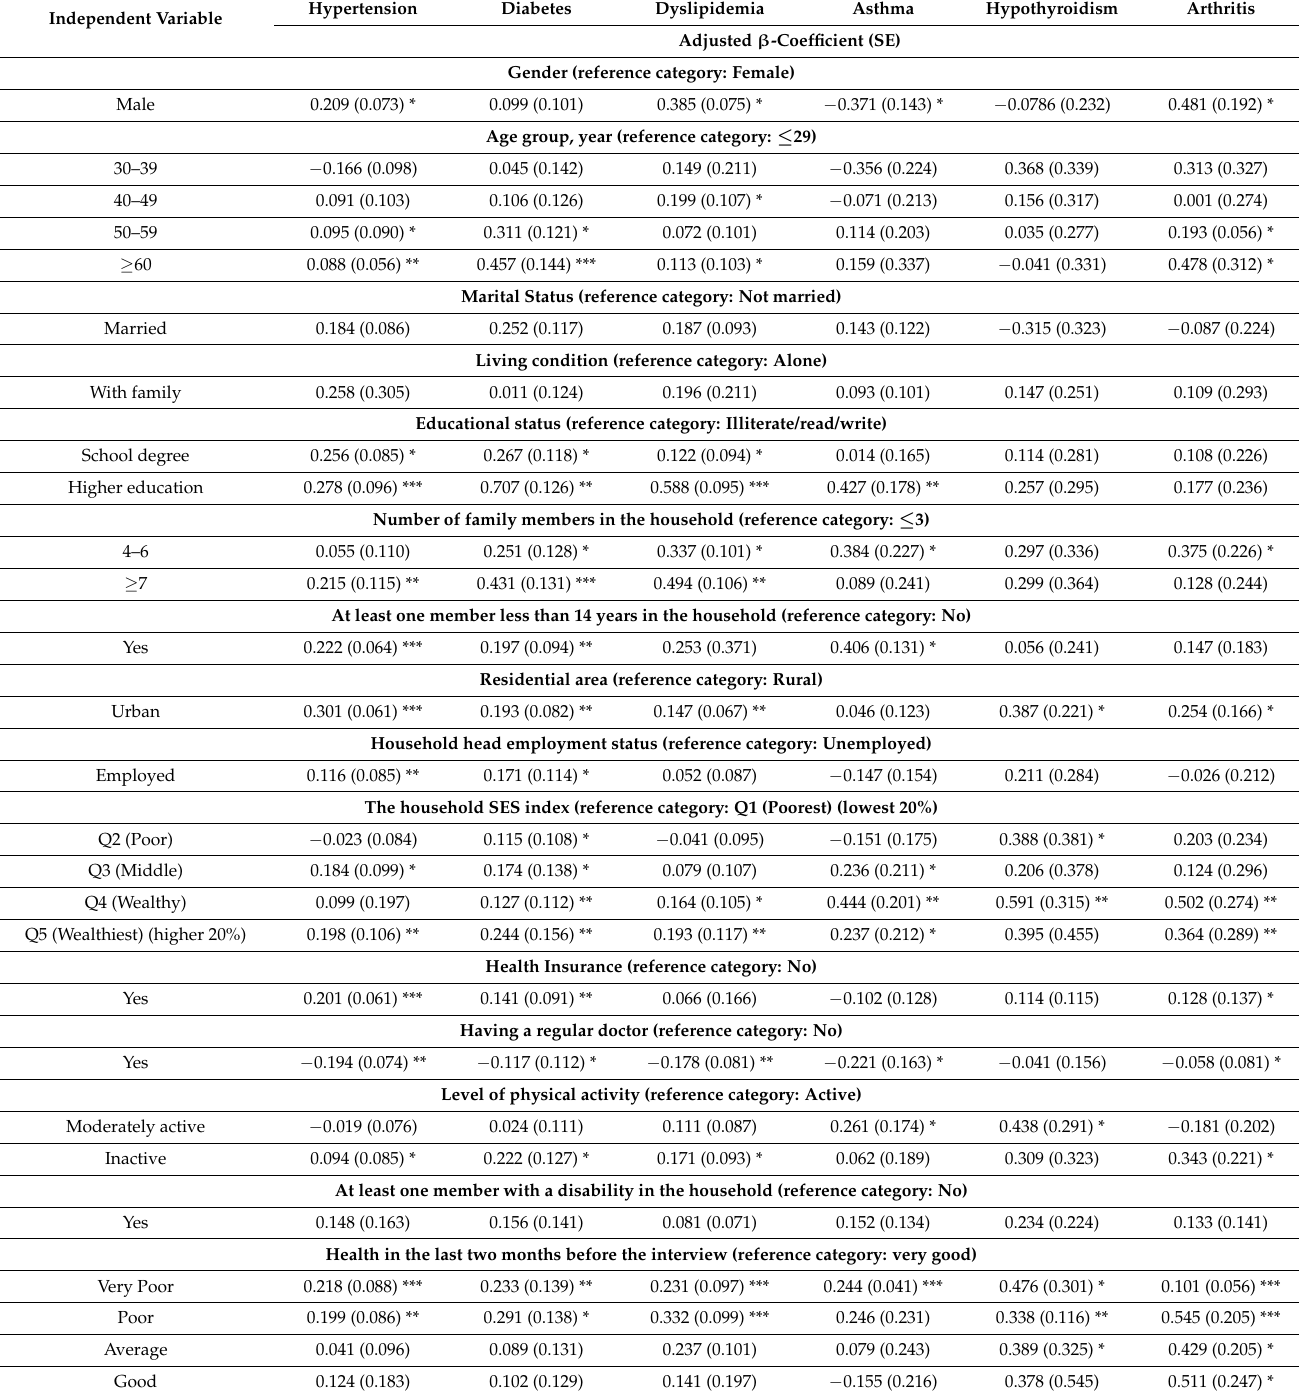
Table 2. Predictors of the total OOP spending level due to NCDs: generalized linear